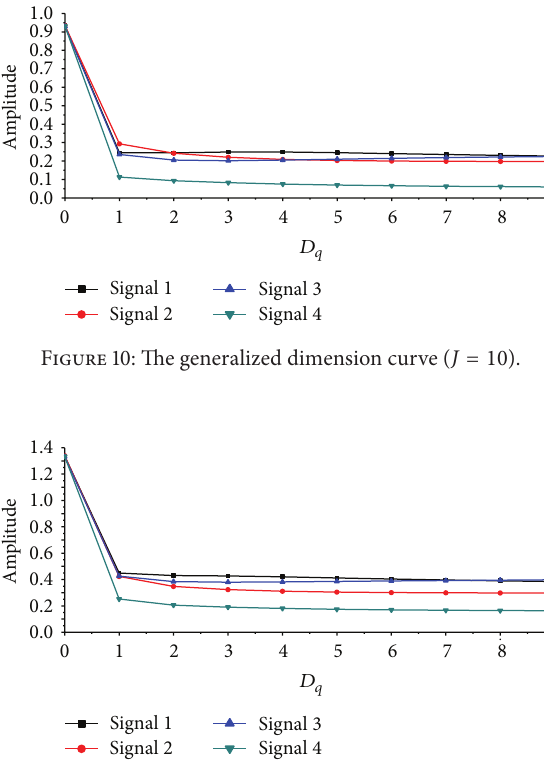
Figure 11: The generalized dimension curve ( 𝐽 = 20 ).